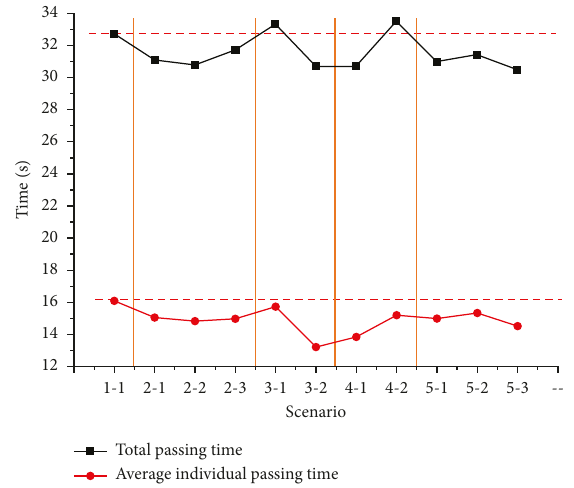
Figure 5: Passing time under different